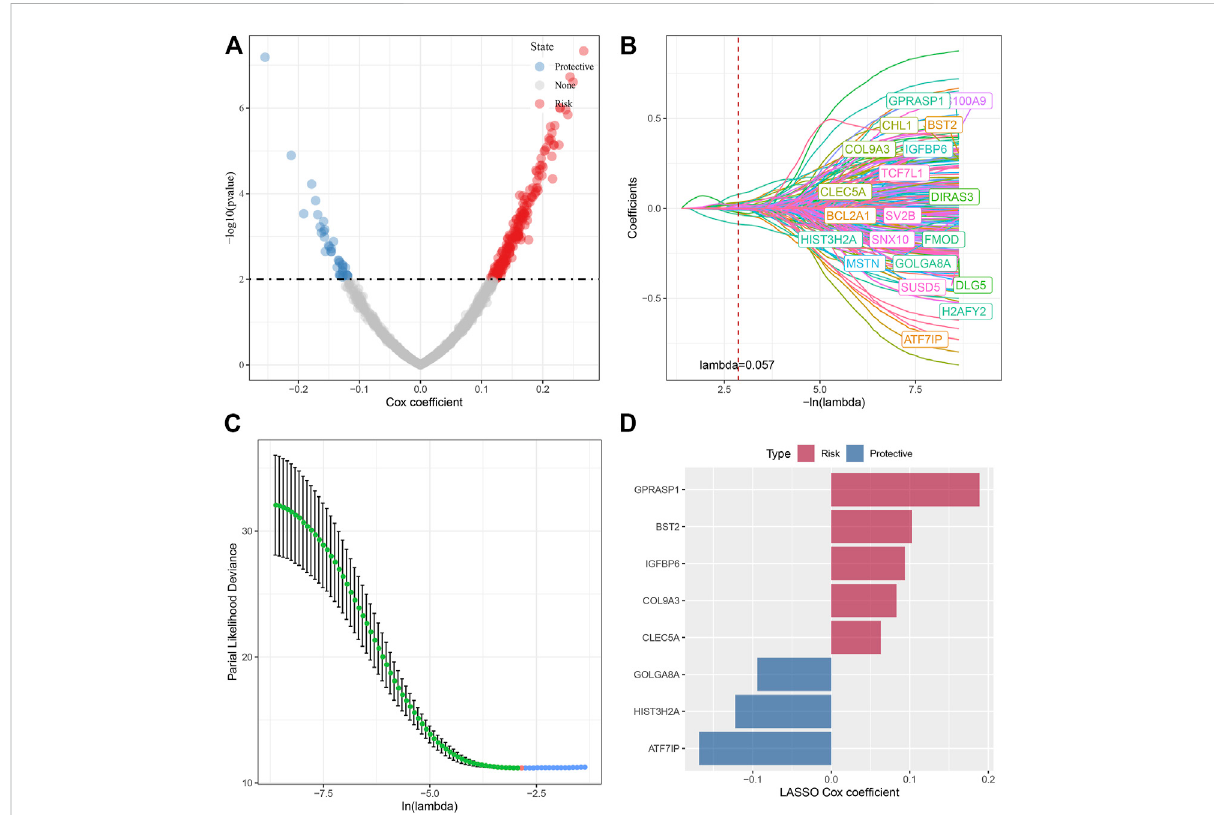
FIGURE 6 Screening of key genes in cell senescence-related pathways. (A) A total of 232 promising candidates were identi fi ed among the DEGs; (B) The path of each argument as lambda changes; (C) Con fi dence interval under lambda. (D) Distribution of lasso coef fi cients of the senescence-related gene